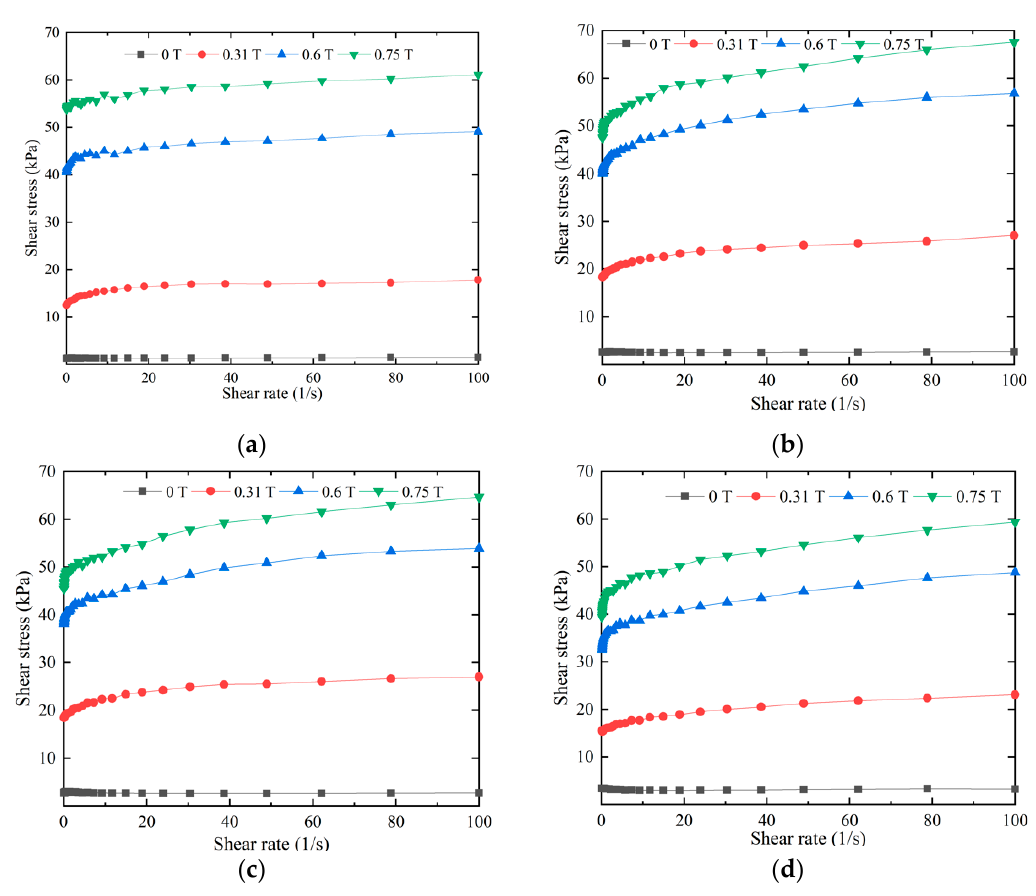
Figure 7. Variation of shear stress with shear rate of four composite samples under different excita- tions. ( a ) the 0 wt% sample, ( b ) the 1 wt% sample, ( c ) the 1.5 wt% sample and ( d ) the 2 wt% sample.